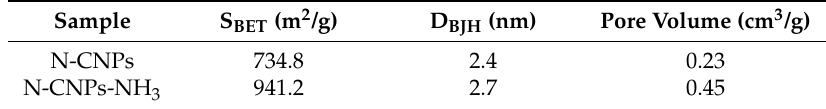
Table 1. Specific surface areas and pore size distribution of N-CNPs and N-CNPs-NH 3 .